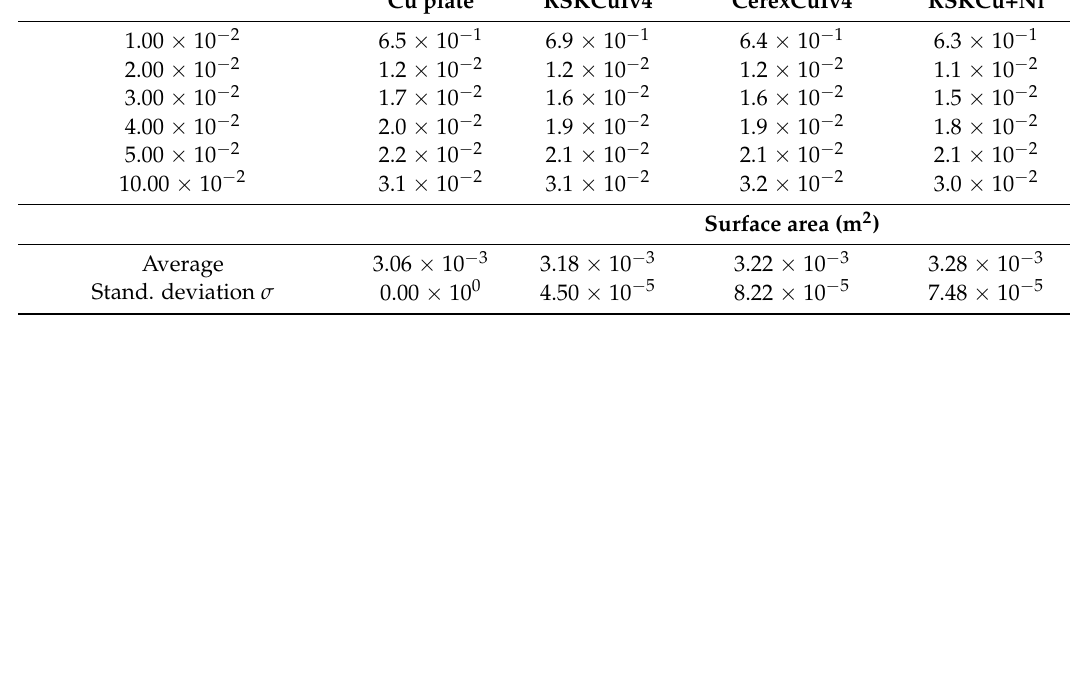
Table 14. The measurement results of the resistance between two electrodes: Cu plate + (Cu plate, CerexCuIv4, RSKCu+Ni, or RSKCuIv4). Distance between Electrodes